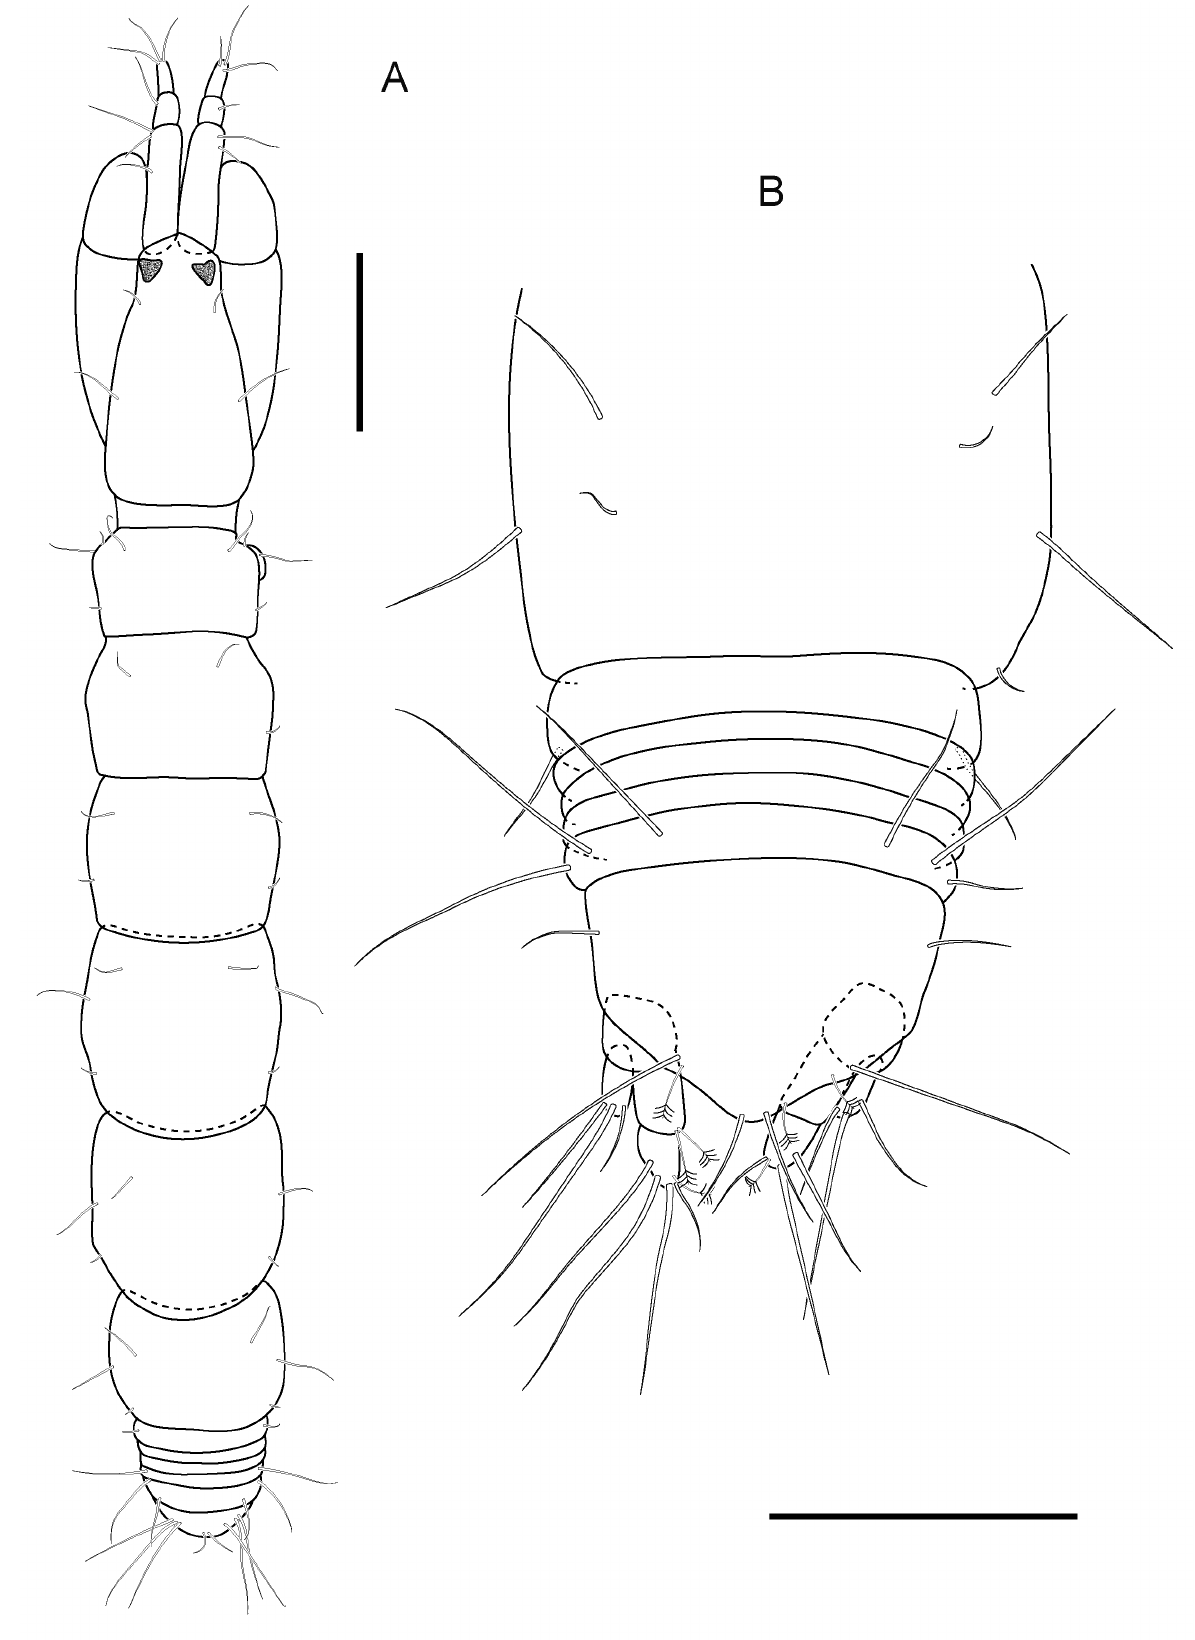
Figure 9. Pseudozeuxo fischeri sp. nov. Paratype, female dissected (MNRJ 29869). A Dorsal view; B enlargement of pleon and pleotelson. Scale bars: 0.1